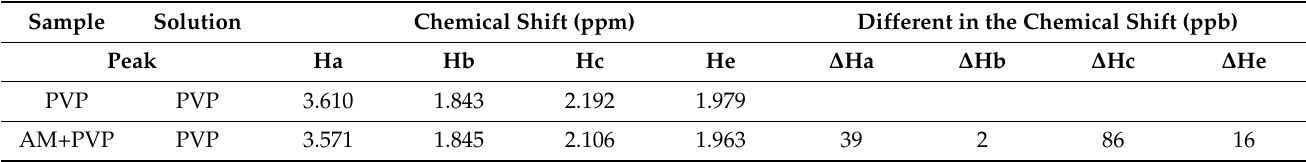
Table 2. Result of viscosity measurement of each sample.